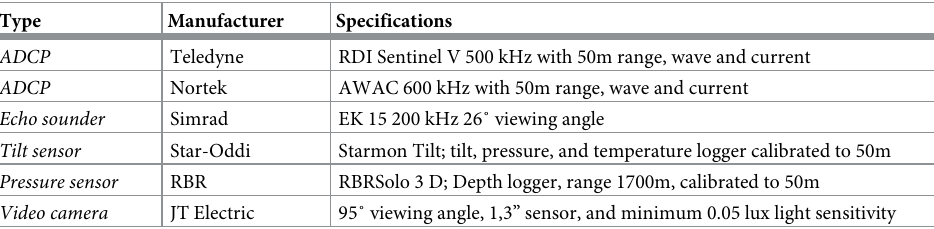
Table 1. Equipment